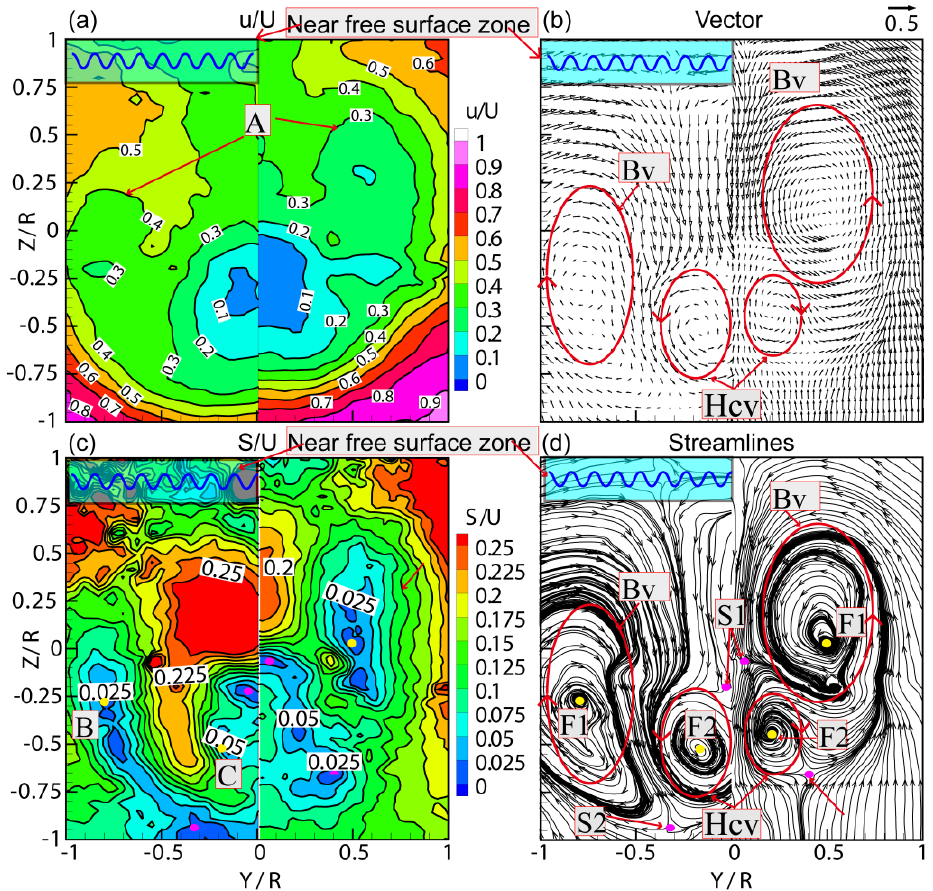
Figure 3. The time-averaged characteristics of the velocity information in the propeller plane: ( a ) dimensionless axial flow velocity u / U ; ( b ) the cross-flow vector; ( c ) dimensionless cross-flow velocity S / U ; ( d ) streamline. For ( a – d ), Left . The ballast condition; Right . The design condition.